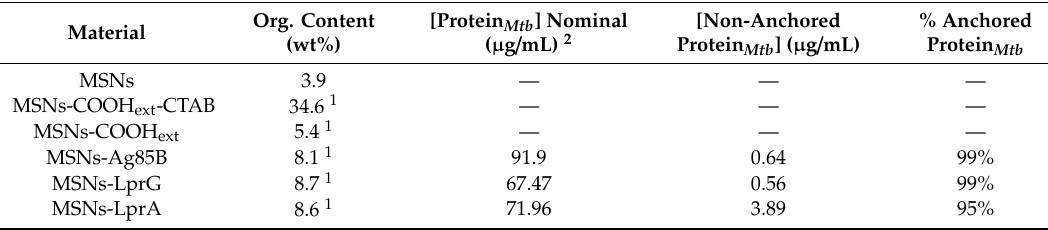
Table 1. Organic content from thermogravimetric analysis of MSNs and functionalized MSNs materials. Concentration of non-anchored protein from Bradford assay of protein functionalized MSNs.